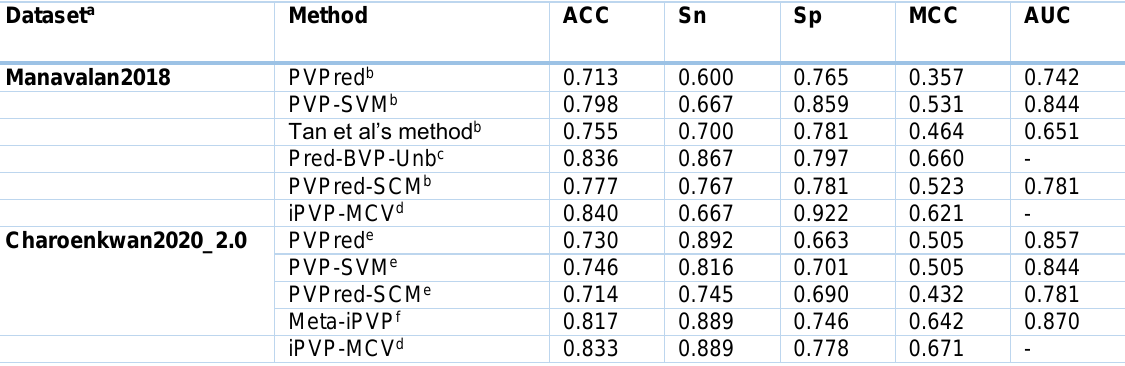
Table 5: Independent test results from different PVP predictors as evaluated on Manavalan2018 and Charoenkwan2020_2.0